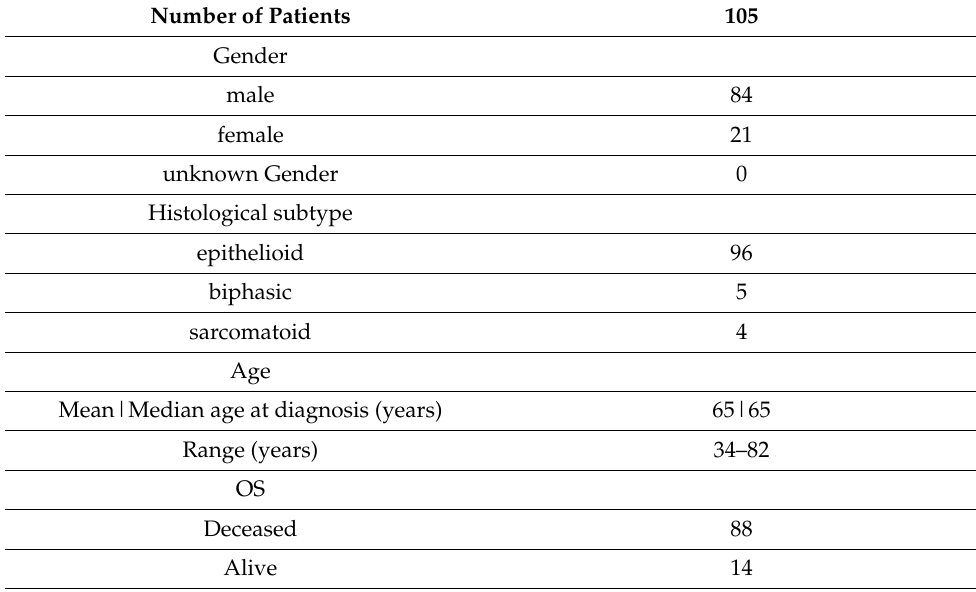
Table 1. Overview of clinicopathological